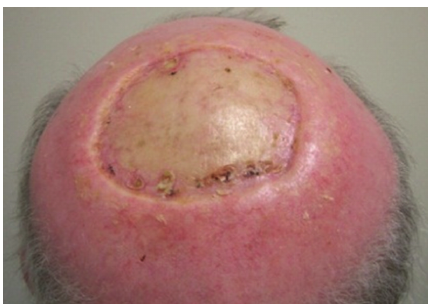
Figure 2: Superior view of the lesion after initial 20Gy and postdressing removal. A fortnight after the first 20Gy, acute haemostasis was achieved to enable safe removal of compression bandage. The green line delineates the lesion.